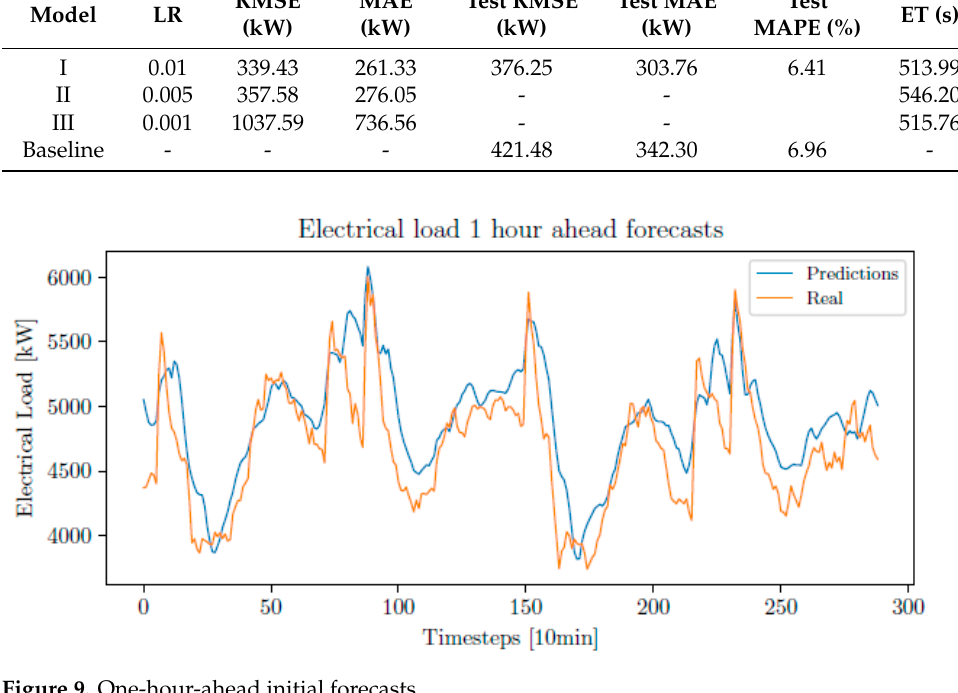
Table 5. Results of the 12-h-ahead initial and baseline